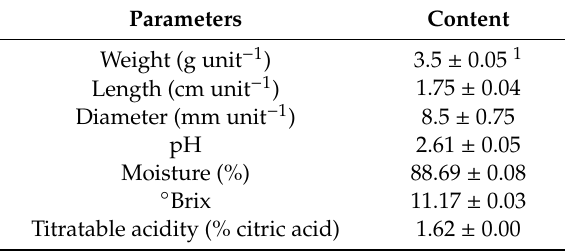
Table 1. Physicochemical characterization of Andean blueberry ( Vaccinium floribundum